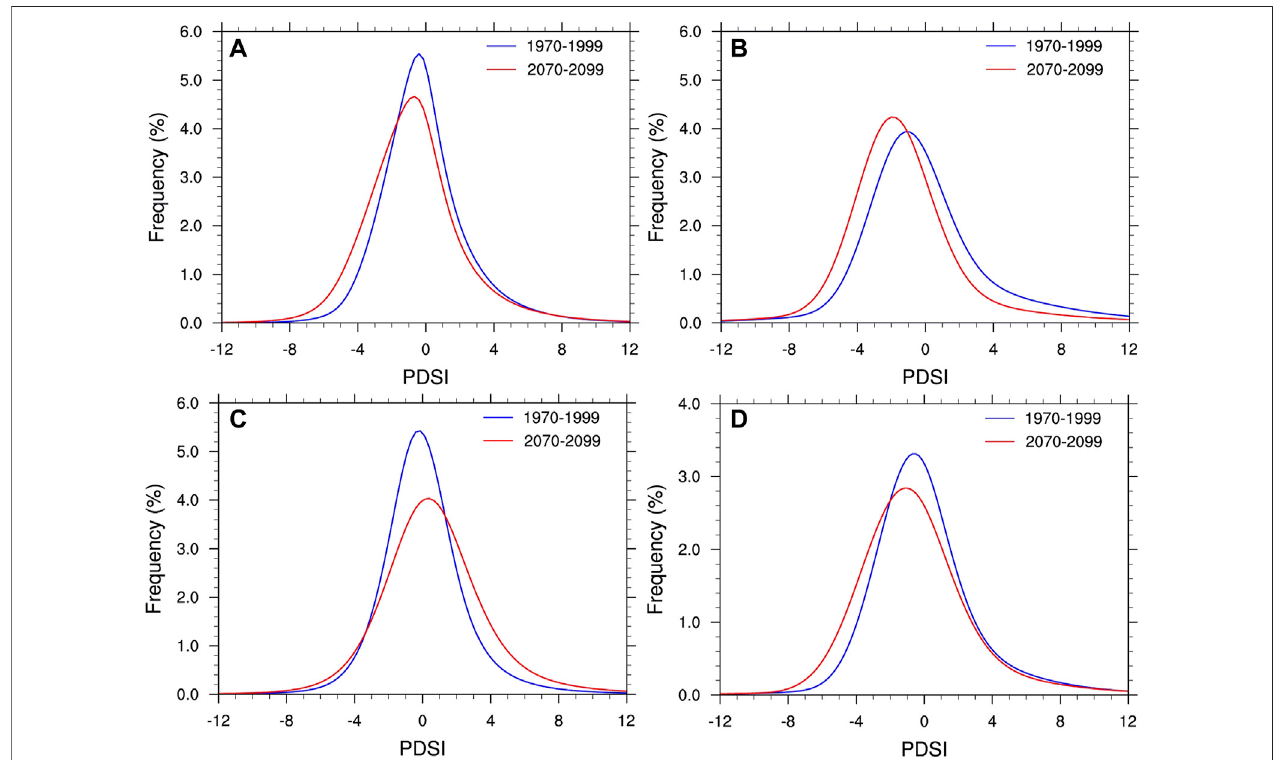
FIGURE 6 | Multi-model ensemble-averaged PDFs of PDSI for 1970 – 1999 and 2070 – 2099 averaged over the grids with robust changes in severe drought frequency due to the changes in both mean and shape for (A) Type I, (B) Type II and (C) Type III regions in Figures 3A and (D) over the robust grids in Figure 2C .